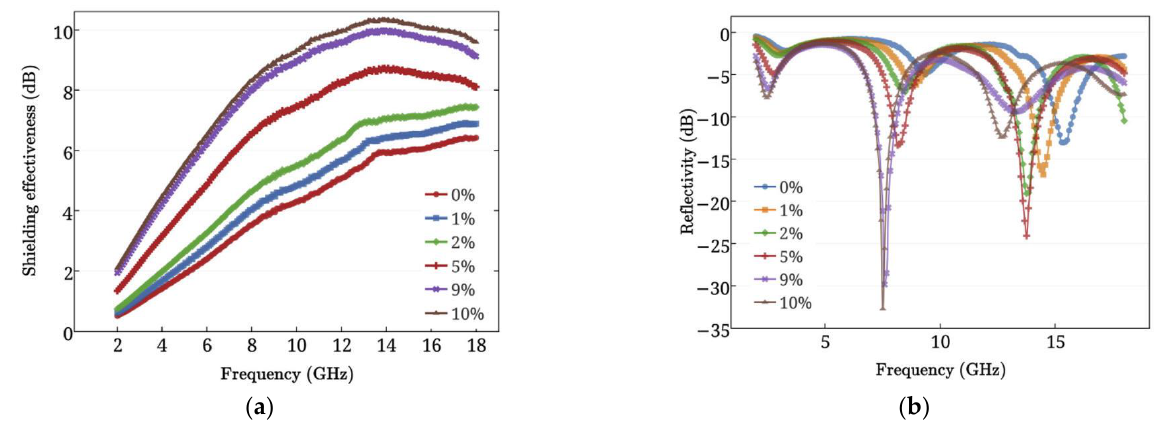
Figure 30. ( a ) Shielding effectiveness and ( b ) Reflectivity of GRCCMs. Reprinted with permission from Ref. [46]. Copyright 2017 Elsevier.